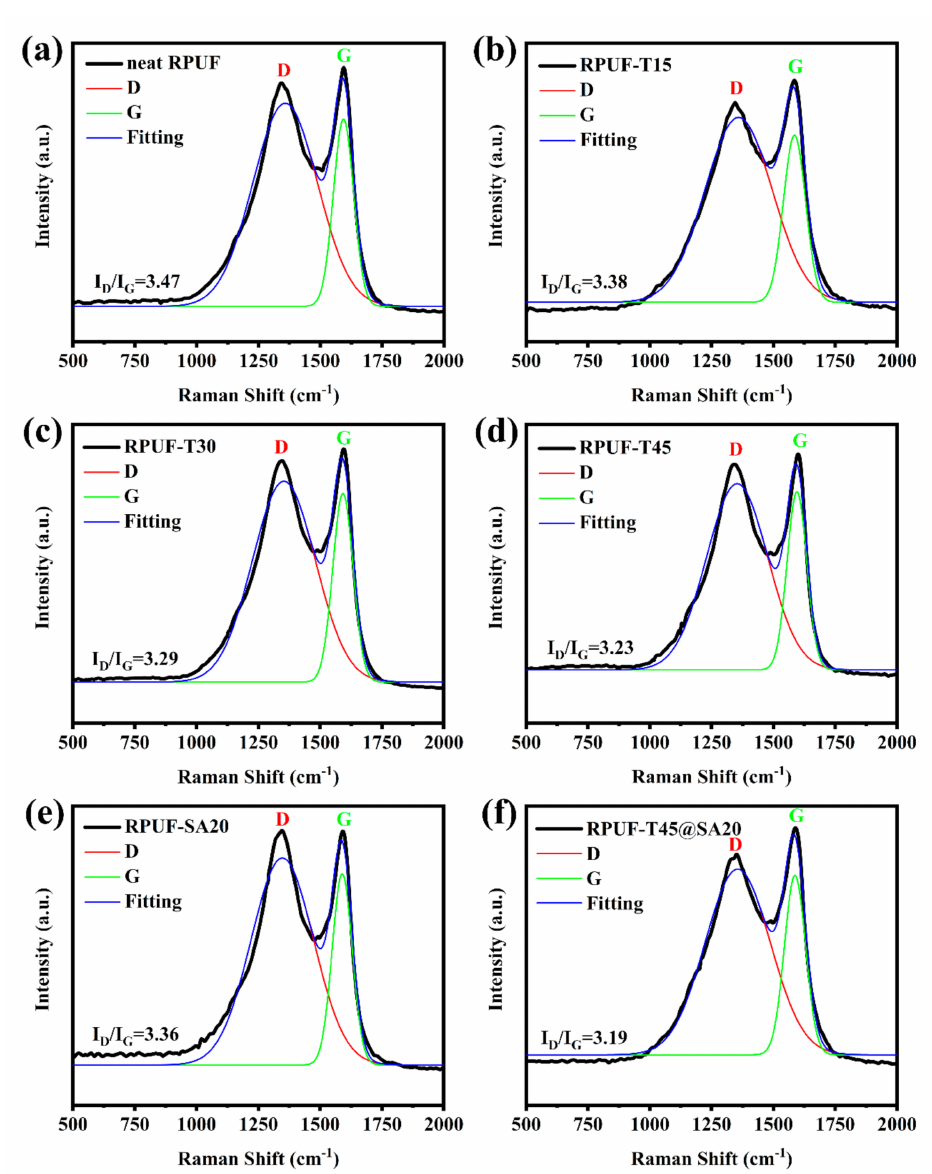
Figure 9. Raman curves of char residues of neat RPUF ( a ), RPUF–T15 to RPUF–T45@SA20 ( b – f